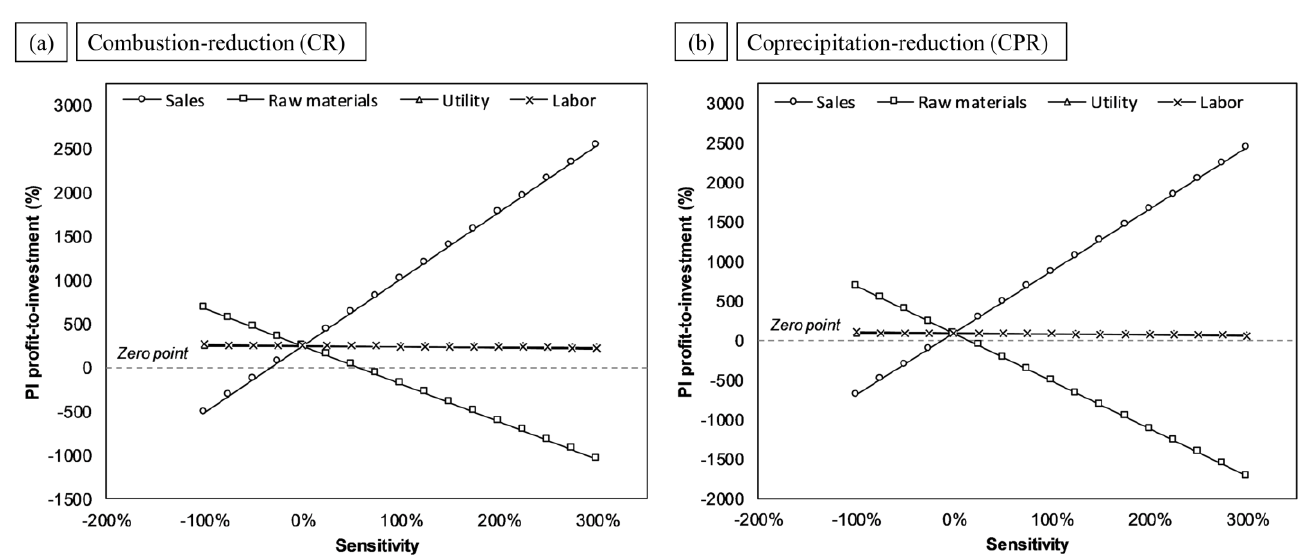
Fig. 7. Analysis of PI profit-to-investment as a function of sales, raw materials, utility, and labor for (a) combustion-reduction (CR) and (b) co-precipitation- reduction